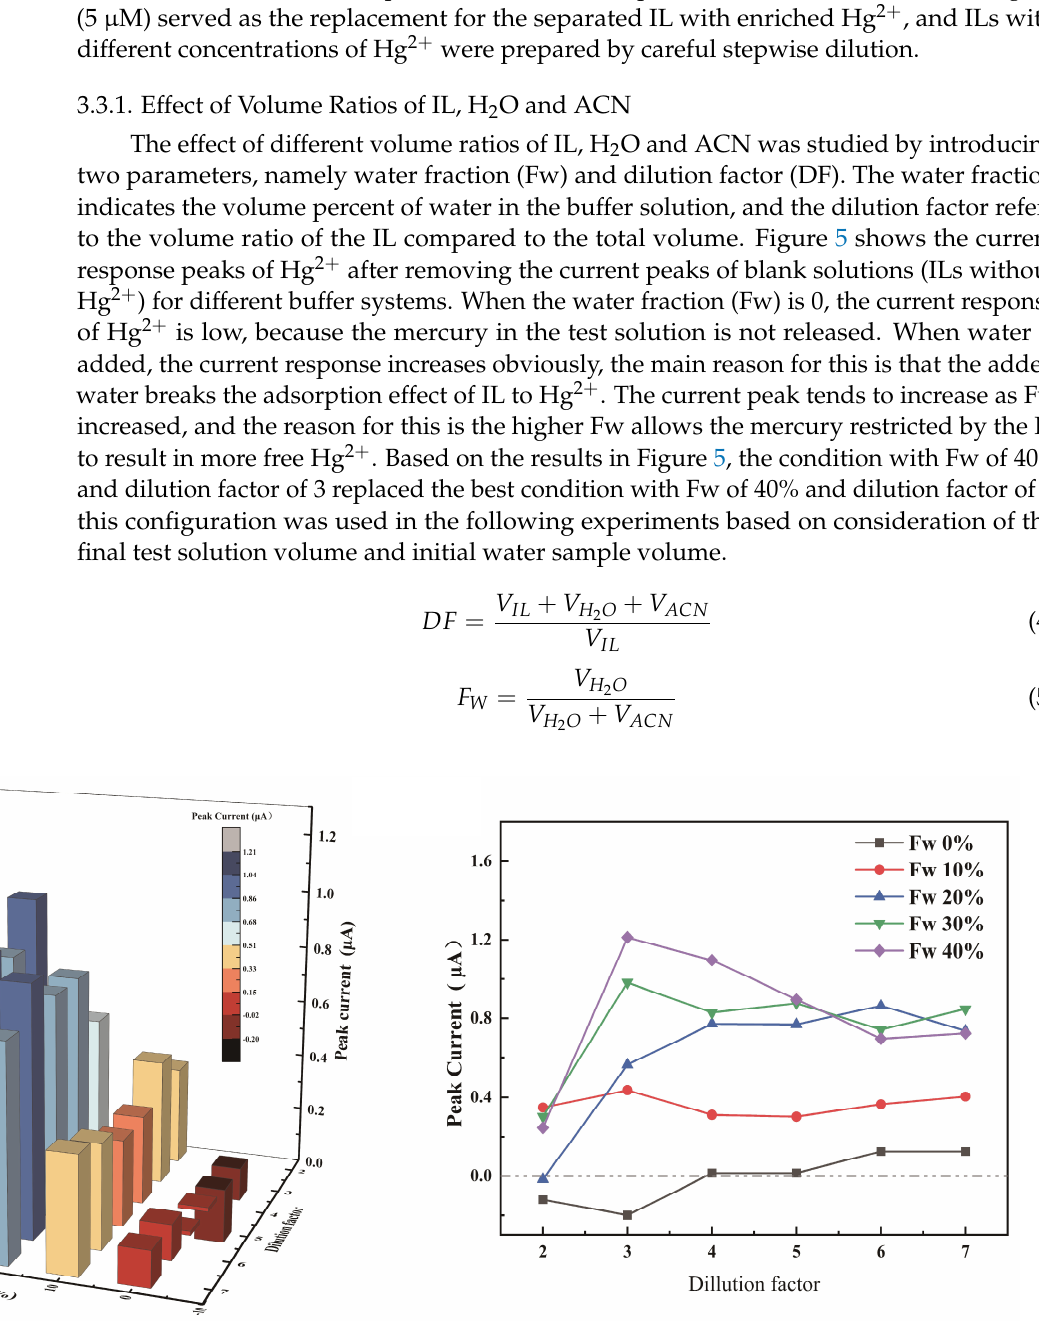
Figure 5. Effect of the detection solution system. The deposition potential was 0.1 V and the deposition time was 240